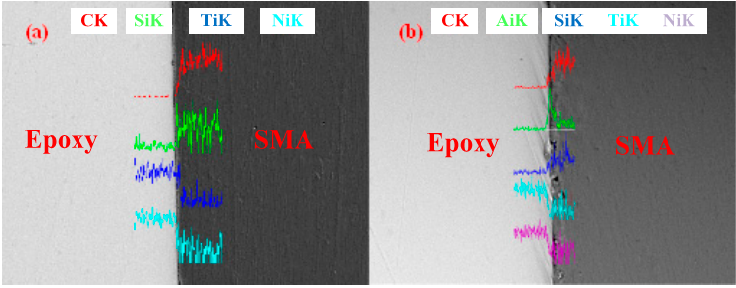
Figure 9. EDX scanning of modified surfaces: ( a ) the initial interface, and ( b ) the nano modified interface.